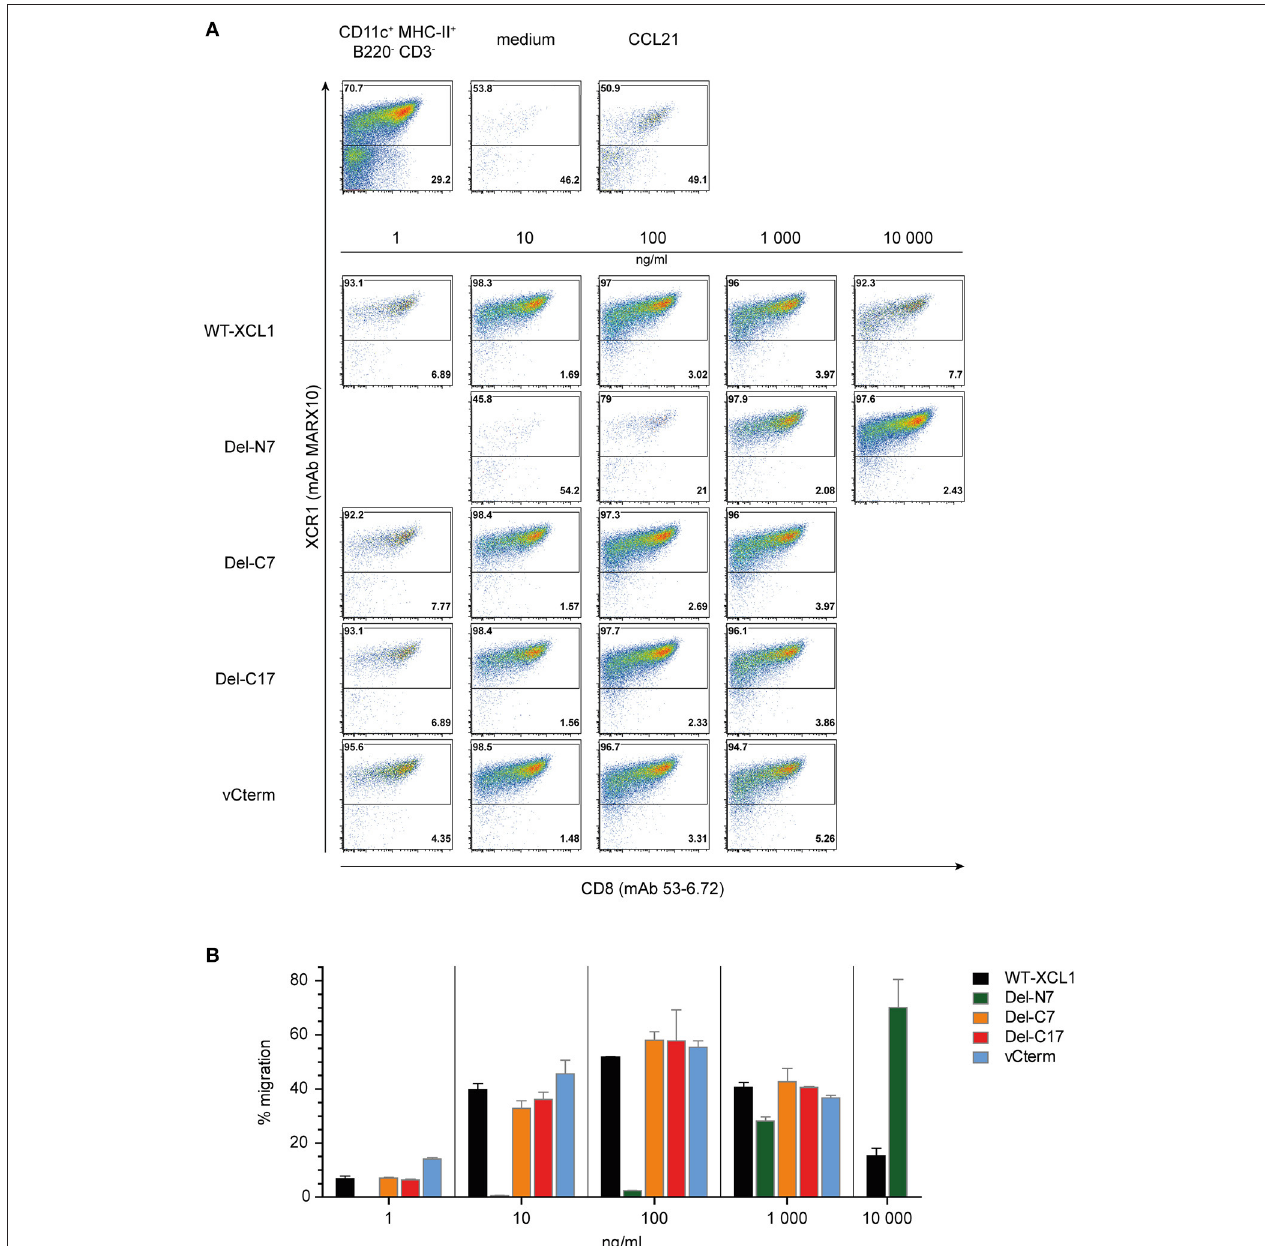
FIGURE 3 | Chemotaxis induced by XCL1-OVA and its variants Del-N7, Del-C7, Del-C17, and vCterm. (A) DC enriched from splenocytes by density gradient centrifugation were placed in the upper chamber of a transwell system, the composition of input DC is shown in the leftmost dotplot in the upper pannel. Various concentrations of wt XCL1-OVA and the structural variants were established in the lower chamber and migration of cells was allowed for 2h. All concentrations are given based on the XCL1-component of the constructs. Thereafter, all cells from the lower chambers were quantitatively analyzed by flow cytometry after staining for XCR1 (mAb MARX10 binds to XCR1 independent of XCL1) and CD8 (mAb 53–6.2). Therefore, the number of events in the dot plots directly represent the number of cells detected. The effect of the negative (medium) and the positive controls (CCL21) is shown in the upper pannels of dot plots. (B) Quantitave evaluation of migrated XCR1 + DC expressed as percentage of input XCR1 + DC of the experiment shown in (A) . One experiment representative of 2 independent experiments (each independent experiment was done in duplicate on the same day and the data were combined (mean ± SEM).